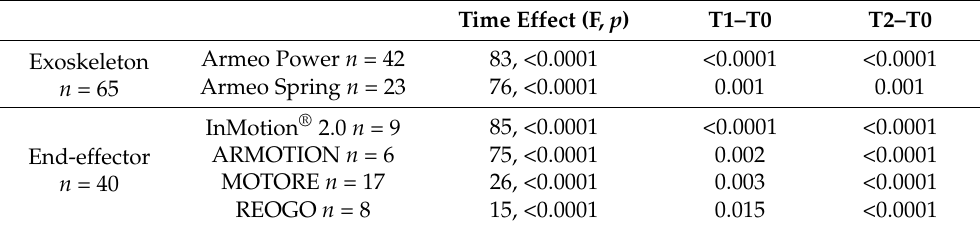
Table 4. Robotic device-specific